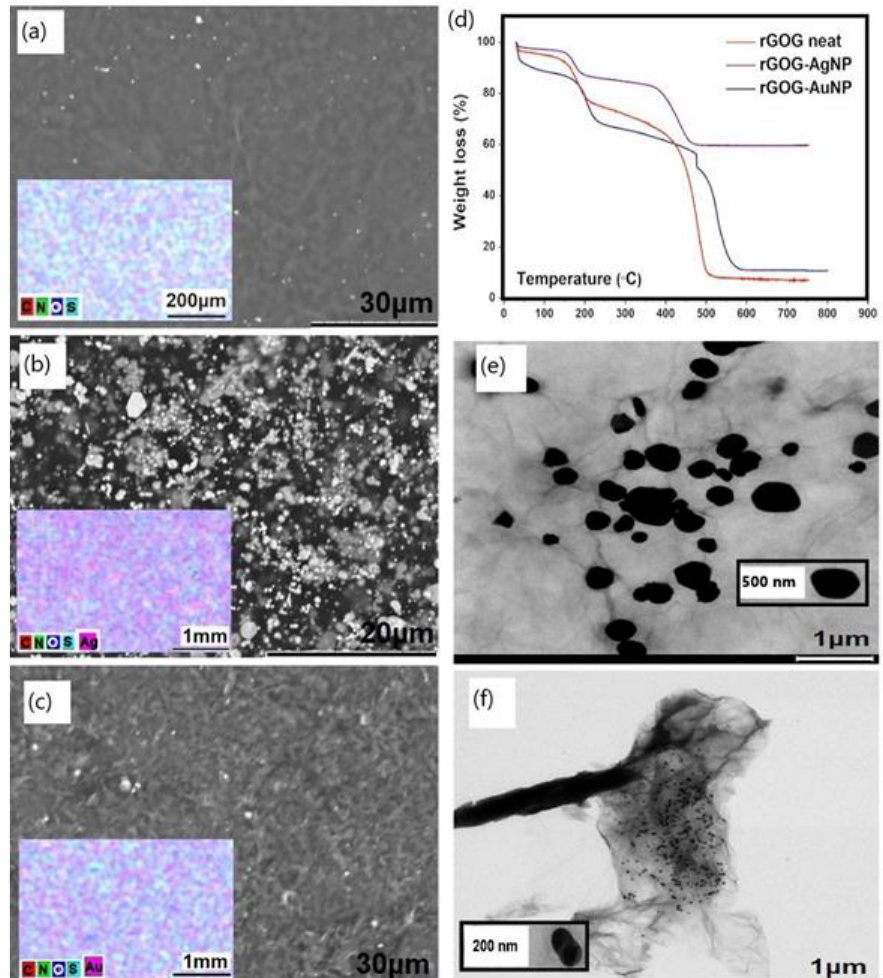
Figure 3. Characteristics of rGOG-AgNP and rGOG-AuNP hybrid films: ( a ) SEM image of neat rGOG, inset: EDX map of the same film; ( b ) SEM image of rGOG-AgNP film, inset: EDX map of the same film; ( c ) SEM image of rGOG-AuNP film, inset: EDX map of the same film; ( d ) TGA curves of hybrid films; ( e ) TEM image of rGOG-AgNP film; ( f ) TEM image of rGOG-AuNP